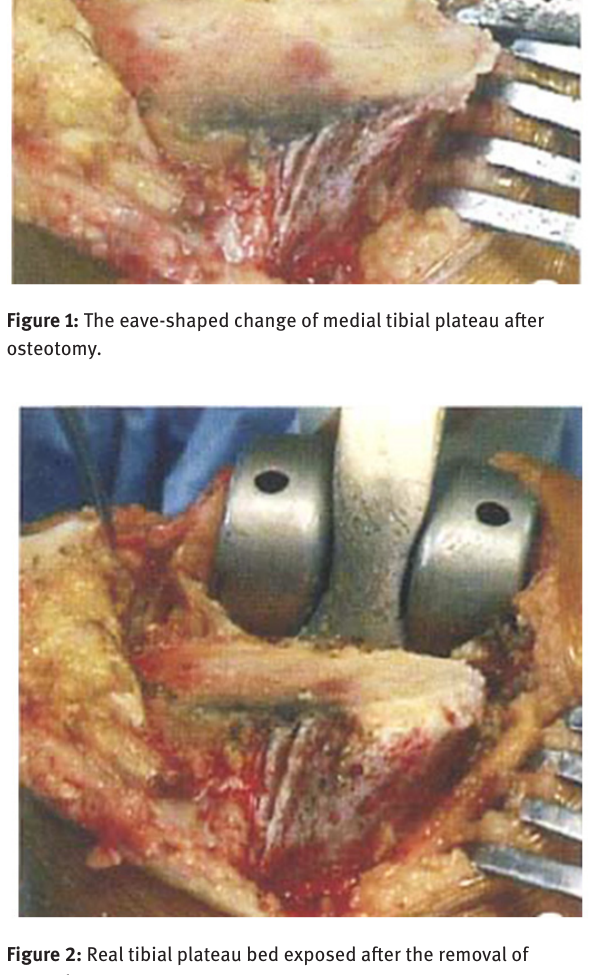
Figure 2: Real tibial plateau bed exposed after the removal of